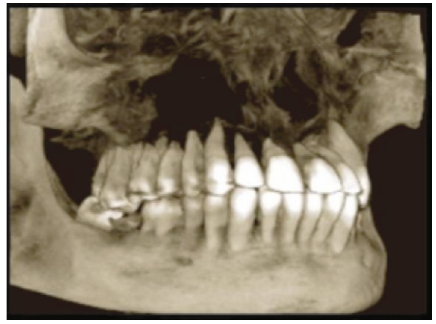
Figure 6: 3D reconstructed CBCT image revealing widespread destruction of maxilla and resorption of all maxillary teeth root apices.